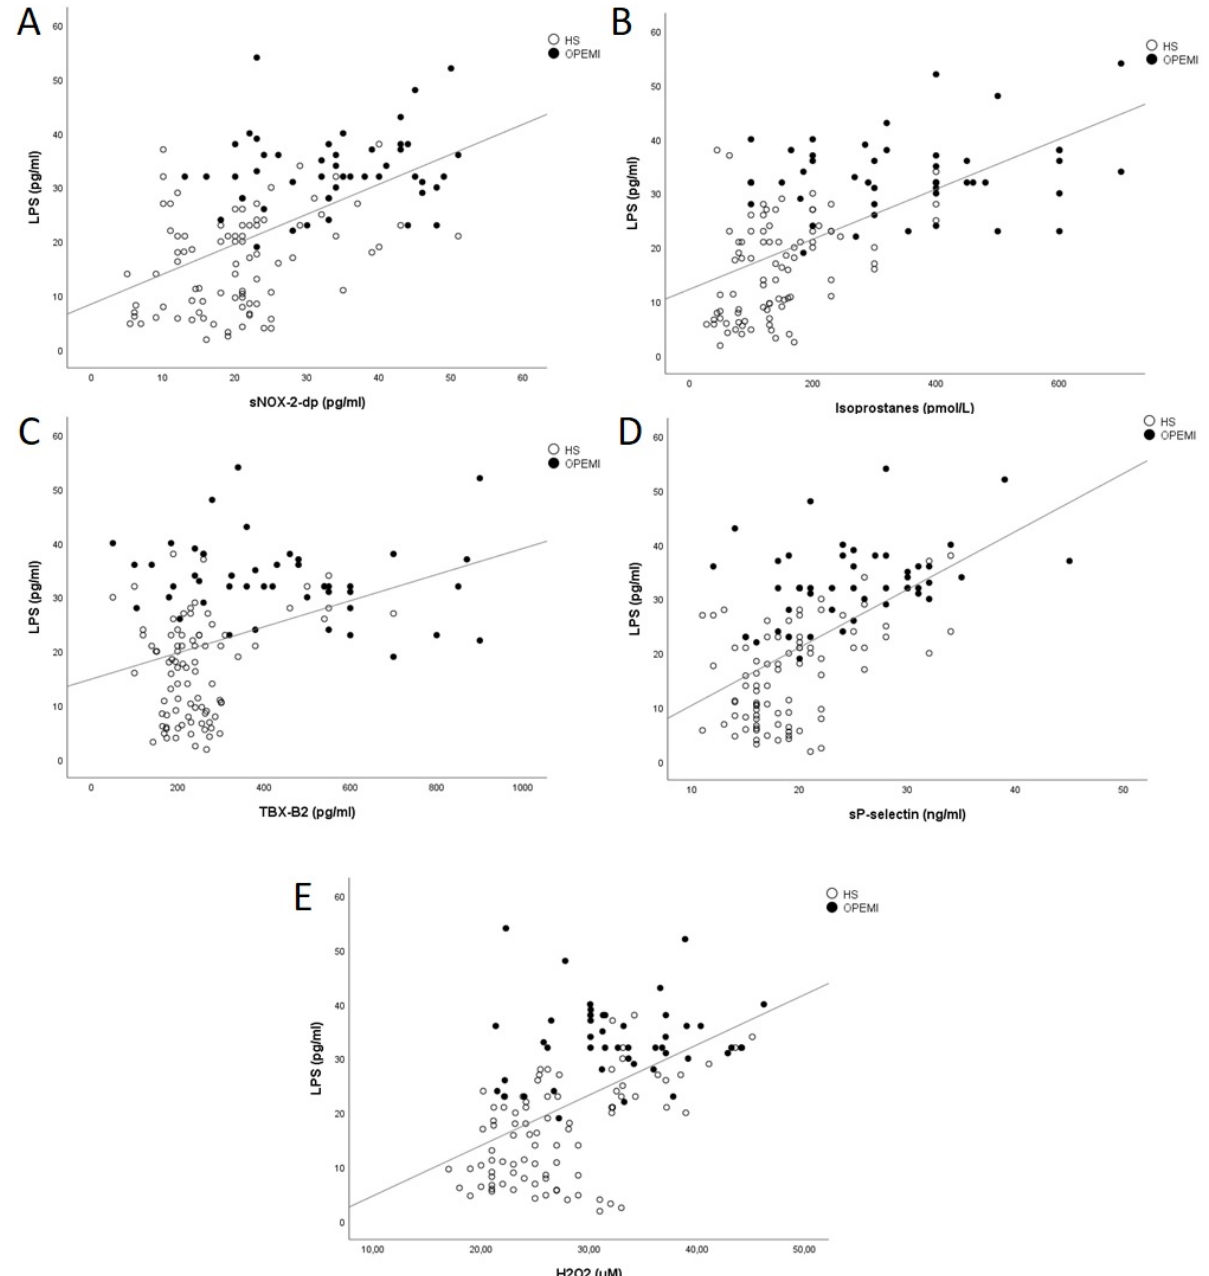
Figure 1. Simple linear regression analysis between serum LPS and NOX2 ( A ), isoprostanes ( B ), TXB2 ( C ), sP-Selectin ( D ) and H 2 O 2 ( E ). OPEMI: offspring of patients with early acute myocardial infarction; HS: healthy subjects; LPS: lipopolysaccharide; NOX-2: NADPH oxidase-type 2; TXB2: Thromboxane B2, H 2 O 2 : Hydrogen Peroxide.